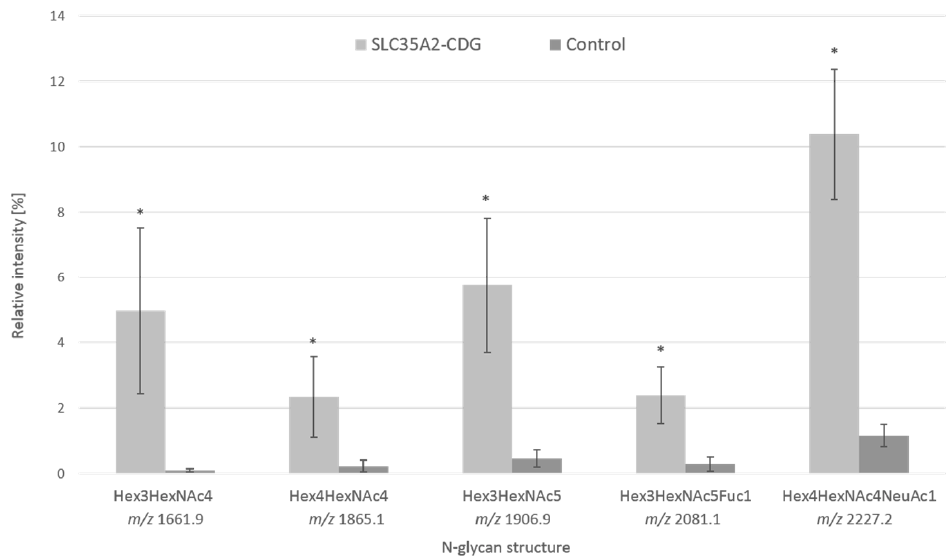
Figure 2. Relative abundance of identified aberrant agalactosylated and monogalactosylated N -glycans. Percentage values were calculated from the total amount of N -glycans identified in the three technical replicates of the patient’s serum and five individual control sera. Fuc—fucose, Hex—hexose, HexNAc— N -acetylhexosamine, NeuAc—sialic acid. * = p ≤ 0.05.